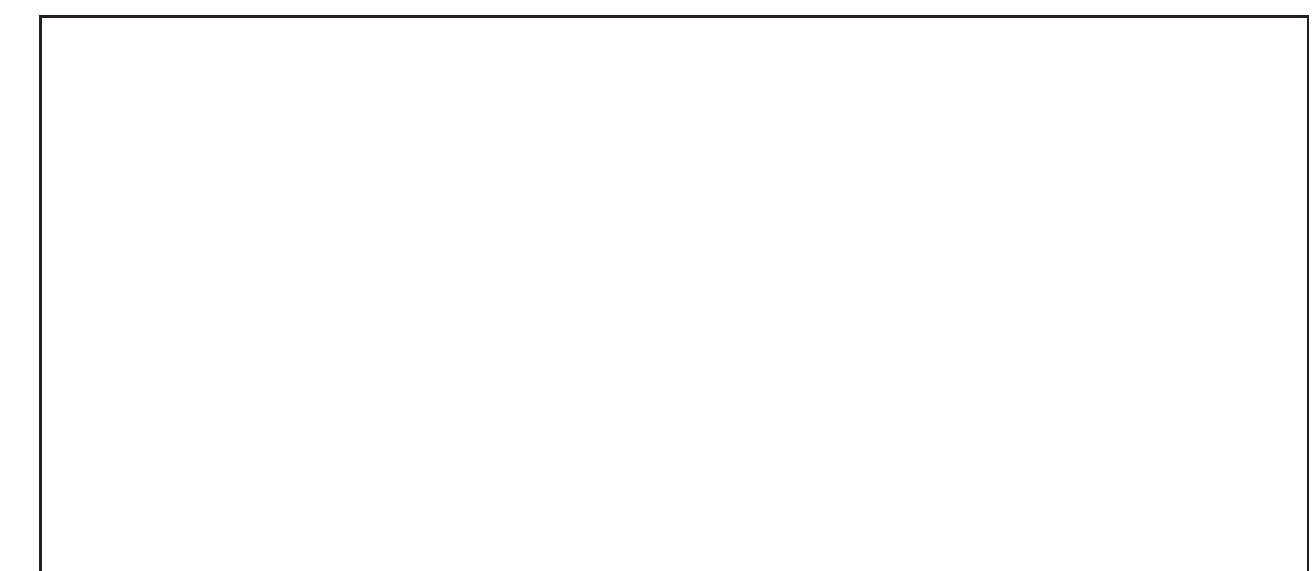
Fig. 1(A,B): Measurement in oblique sagittal MRI images at the slice level 10 mm proximal to the glenoid surface (A) of the combined cross-sectional area of infraspinatus and teres minor muscle